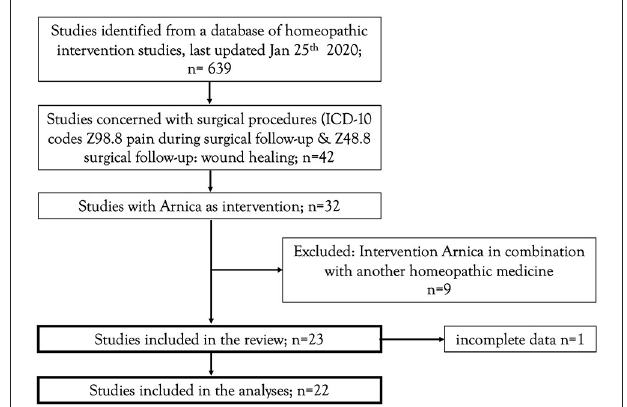
FIGURE 1 | Flowchart of studies included in the